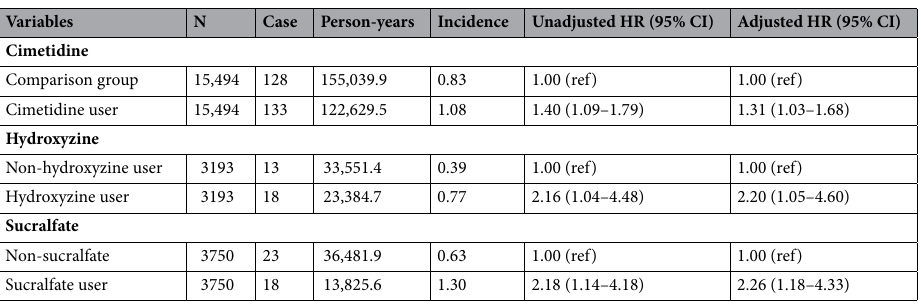
Table 1. Incidence per 1000 person-years and HR (95% CIs) of bilateral hearing loss between non-drug user and drug user (cimetidine, hydroxyzine, and sucralfate). HR, hazard ratio; CI, confidence interval.